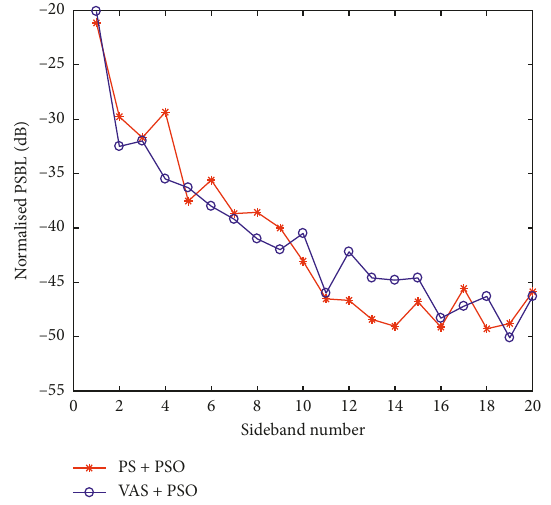
Figure 20: Sideband level comparison in the PS and VAS